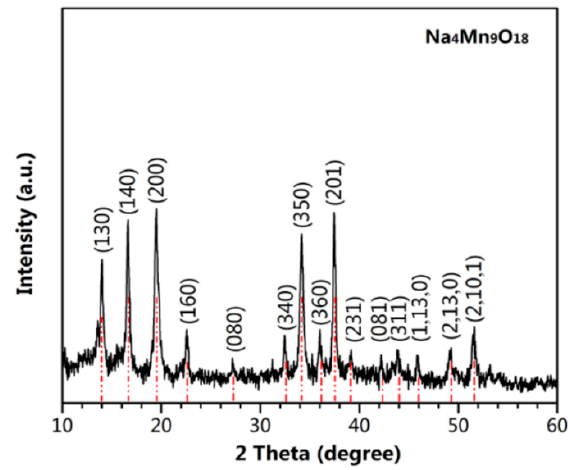
Figure 2. XRD pattern of Na 4 Mn 9 O 18 .